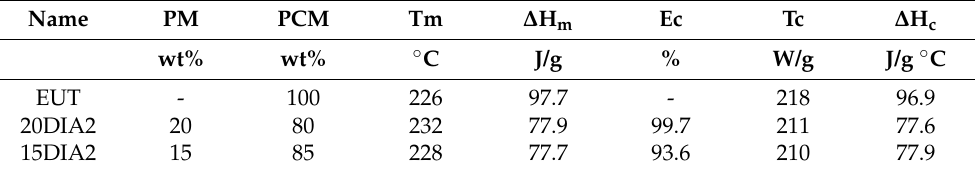
Table 2. Thermal characteristics of the microencapsulated PCMs obtained by DSC analysis during the 2nd thermal cycle (transformation enthalpies and temperatures of the main